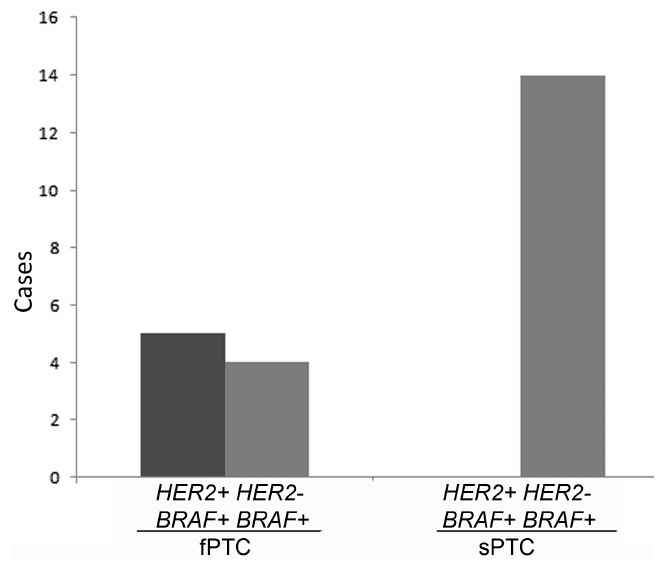
Figure 4. Distribution of HER2 amplification and BRAF V600E mutation in fPTC and sPTC tumors.